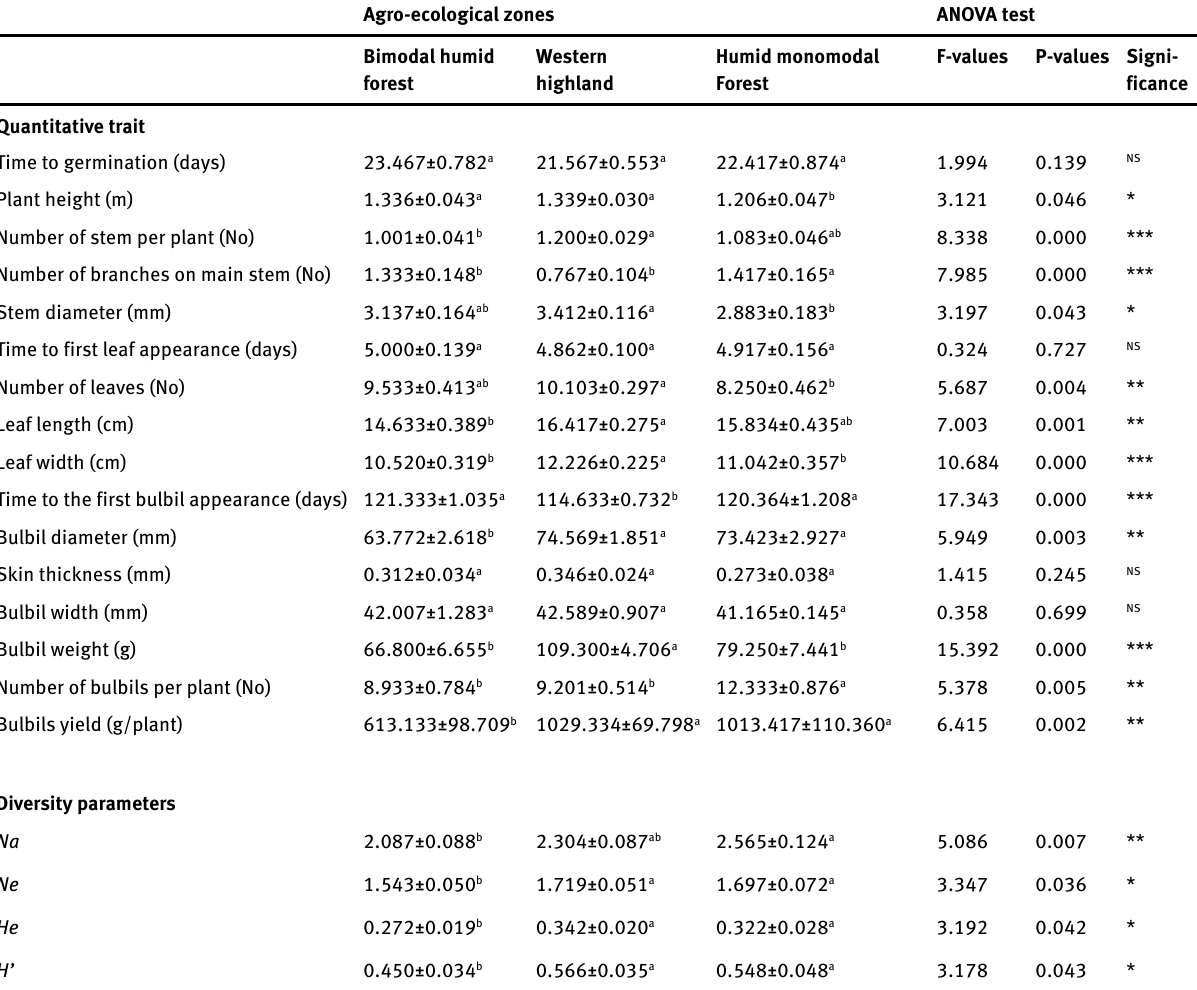
Table 5: Analysis of variances of means of 16 quantitative traits and diversity parameters for Dioscorea bulbifera in three distinct agro-ecolo- gical zones of Cameroon Agro-ecological zones